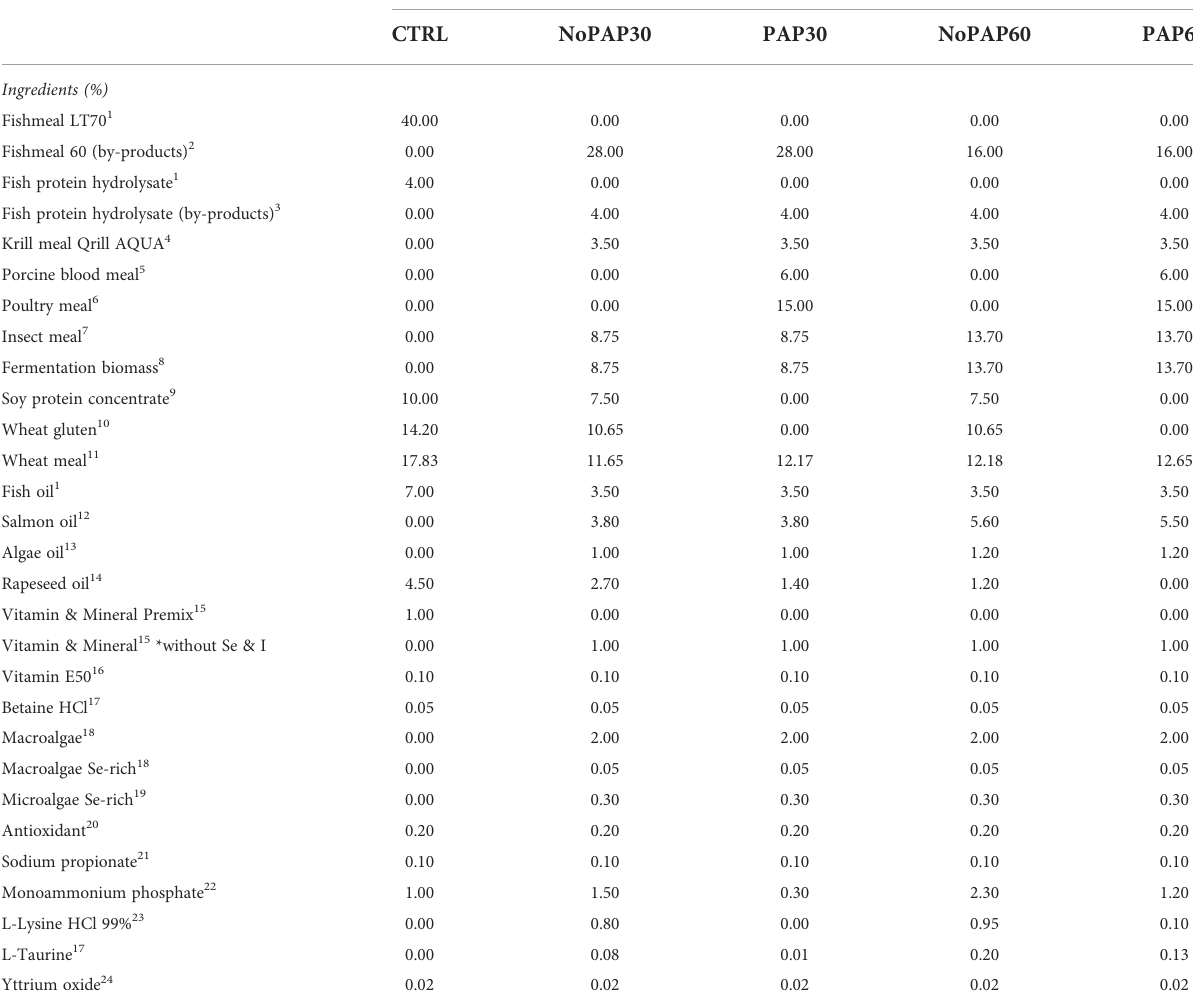
TABLE 1 Formulation of the fi ve experimental diets (Manufacturer of feed ingredients) for market-sized turbot.